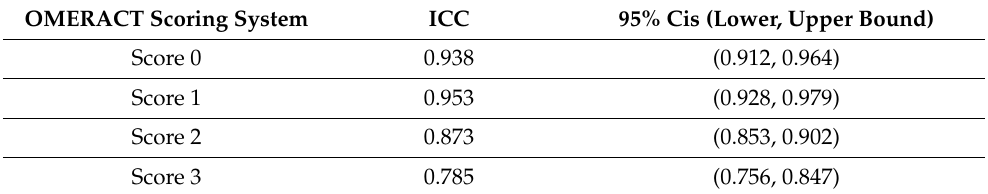
Table 1. Concordance rates classified per score assignment.